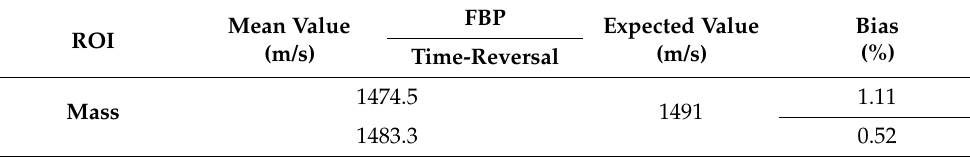
Table 4. Mean value, expected value, and bias of the mass shown in Figure 11 for sound speed